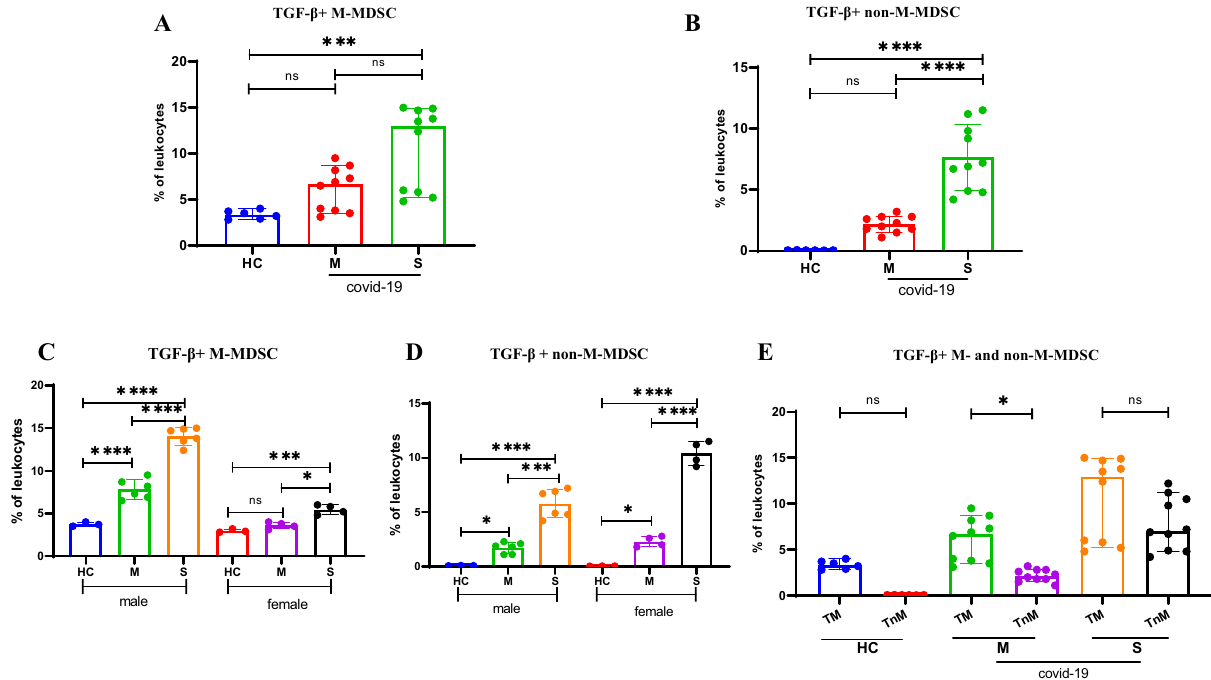
Figure 2. Expression levels of intracellular TGF-β in MDSCs. The frequencies of TGF-β + M-MDSCs ( A ) and TGF-β + non-M-MDSCs ( B ) as the percentage of the CD11b + HLA-DR -/low cells in moderate (M) and severe (S) COVID-19 patients compared with healthy control subjects (HC). The effect of sex on the percentage of TGF-β + M-MDSCs ( C ) and of TGF-β + non-M-MDSCs ( D ) is also shown. ( E ) Frequency of TGF-β + M-MDSCs compared to non-M-MDSCs in HC and COVID-19 patients (both M and S). All values are presented as the mean or median and 5–95% percentile and comparisons made between control and patient groups were performed using ANOVA or Kruskal–Wallis followed by a the Tukey’s or Dunn’s tests for normally distributed or non-normally distributed data respectively.*P < 0.01, **P < 0.001, ***P < 0.0001 and ****P < 0.0001. HC healthy control, M moderate, S MDP and homologous PBMCs on CD4 + CD25 + Foxp3 + cell frequency. Co-culture of autologous MDSCs, sig- nificantly suppressed the expansion of PHA-stimulated CD4 + CD25 + Foxp3 + T cells (Fig. 5A). No significant difference was seen on the frequency of CD4 + CD25 + Foxp3 + T cells in autologous and homologous co-cultures (Fig. 5A P = 0.9). In contrast, the PHA-induced proliferation and expansion of CD4 + CD25 - Foxp3 + regulatory precursor T cells was significantly enhanced by co-culture with MDSCs from both patients and HCs (Fig. 5B P = 0.002, P = 0.03, respectively). No differences in the increase in CD4 + CD25 - Foxp3 + T cell frequencies were observed in response to culture with autologous and homologous co-cultures (Fig. 5B P = 0.83). Regardless of CD25 expression, the number of CD4 + Foxp3 + T cells in co-culture with MDSCs was also considerably elevated in both patients and HCs (Fig. 5C P = 0.02, P = 0.04, respectively). Serum TGF‑β is elevated in patients with COVID‑19. Serum concentrations of TGF-β in COVID-19 patients and HCs were measured by ELISA. Patients with severe disease had significantly elevated serum lev- els of TGF-β compared with patients with moderate COVID-19 and HCs (P = 0.003, P < 0.0001, respectively). Patients with moderate COVID-19 also demonstrated significantly elevated levels of TGF-β compared to HC (P = 0.0001) (Fig. 6A). TGF‑β release from co‑cultured MDSCs and PBMC.